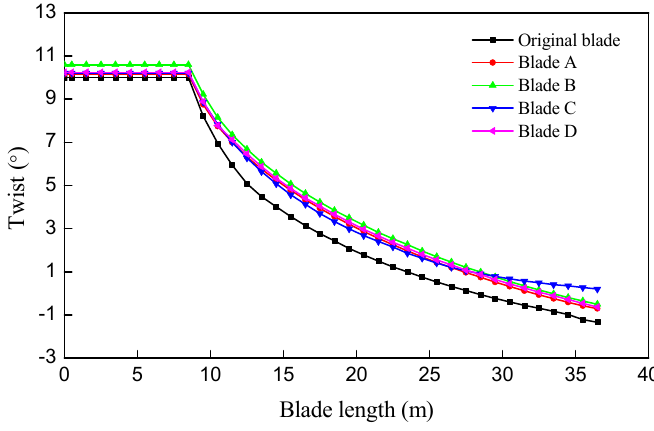
Figure 14. Comparison of twist distributions.